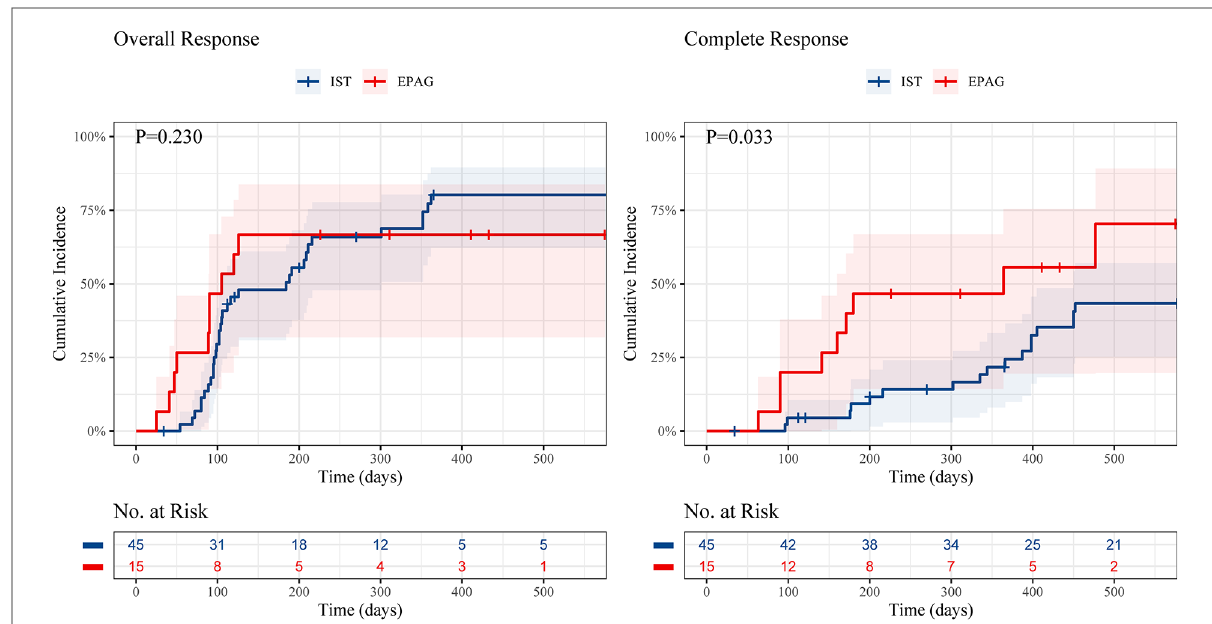
FIGURE 1 Cumulative incidence of overall response and complete response of children in the EPAG and IST group. EPAG, eltrombopag; IST, immunosuppressive therapy.